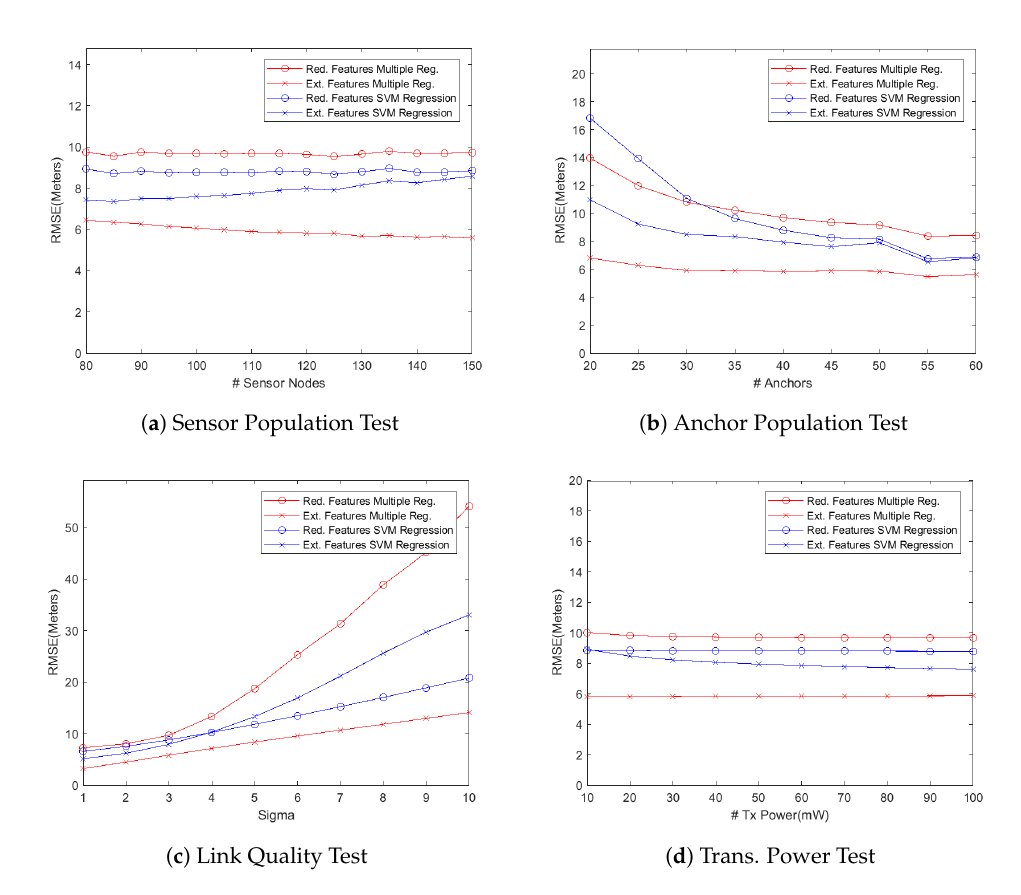
Figure 1. Network with anchors deployed as a grid: Impact of varying different system parameters on the performance metric (i.e., localization